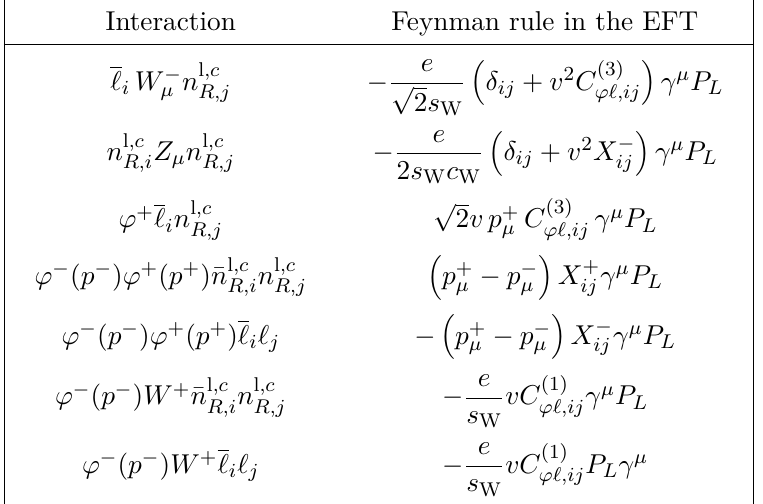
Table 2. Feynman rules for the relevant operators of the SMEFT for vanishing charged lepton masses. The tree-level results for C (3)